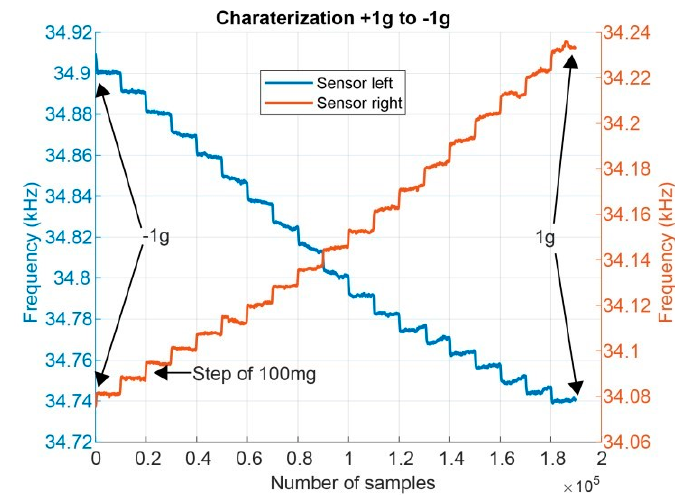
Figure 4. A device was dynamically characterized from +1 g to − 1 g and a motor with a high rotational precision was used to make steps of 100 mg. Furthermore, the system implemented was able to